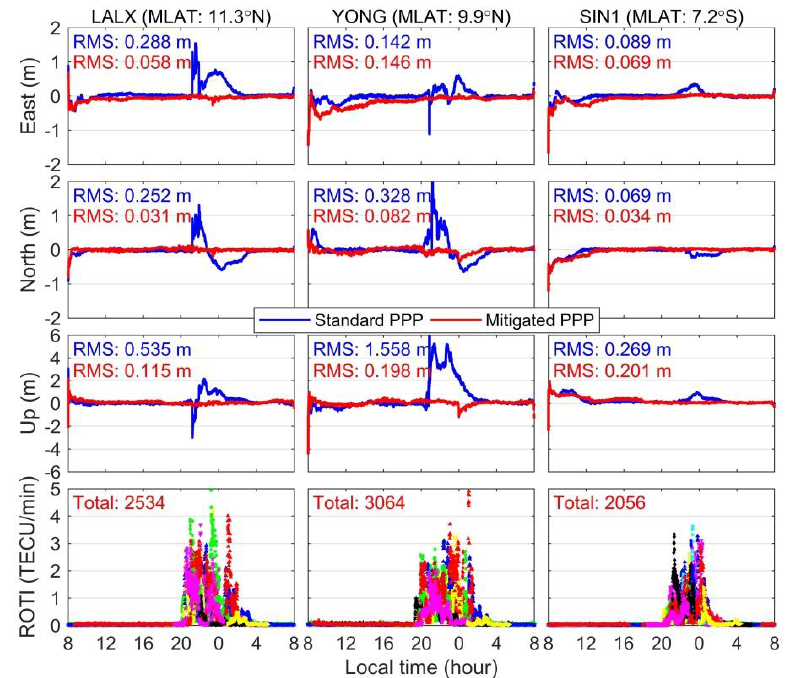
Figure 15. BDS Positioning results of standard and mitigated PPP solutions for different area stations as LALX, YONG, and SIN1 on 13 March 2015 (DOY 72).